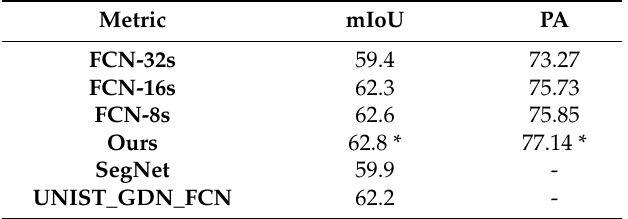
Table 5. The mean intersection over union (mIoU) and pixel accuracy (PA) scores of all the methods.